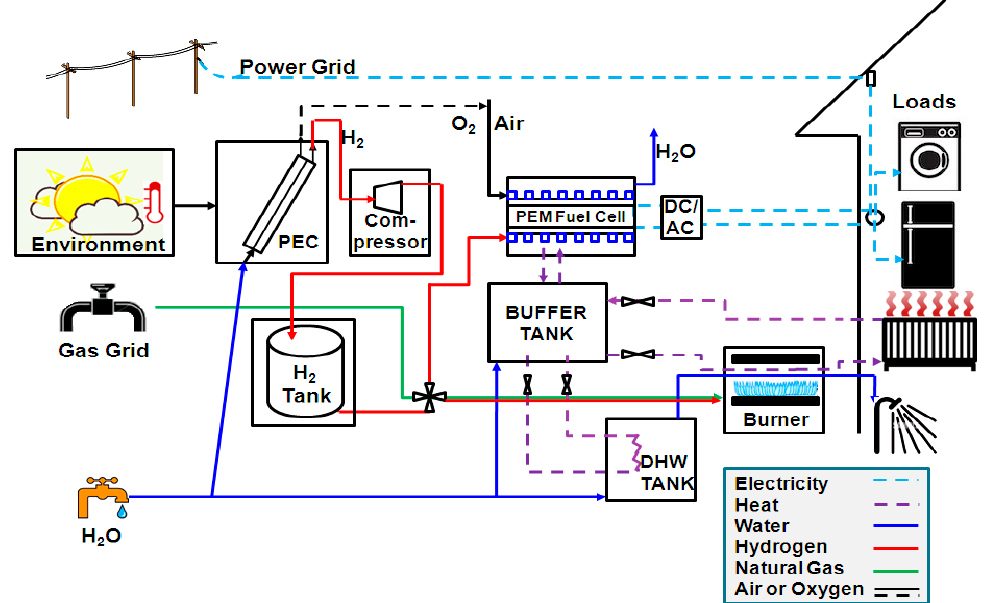
Figure 1. Schematic of a potential solar-photo-electrochemical (PEC)-hydrogen domestic micro-CHP (micro-combined heat and power) system.